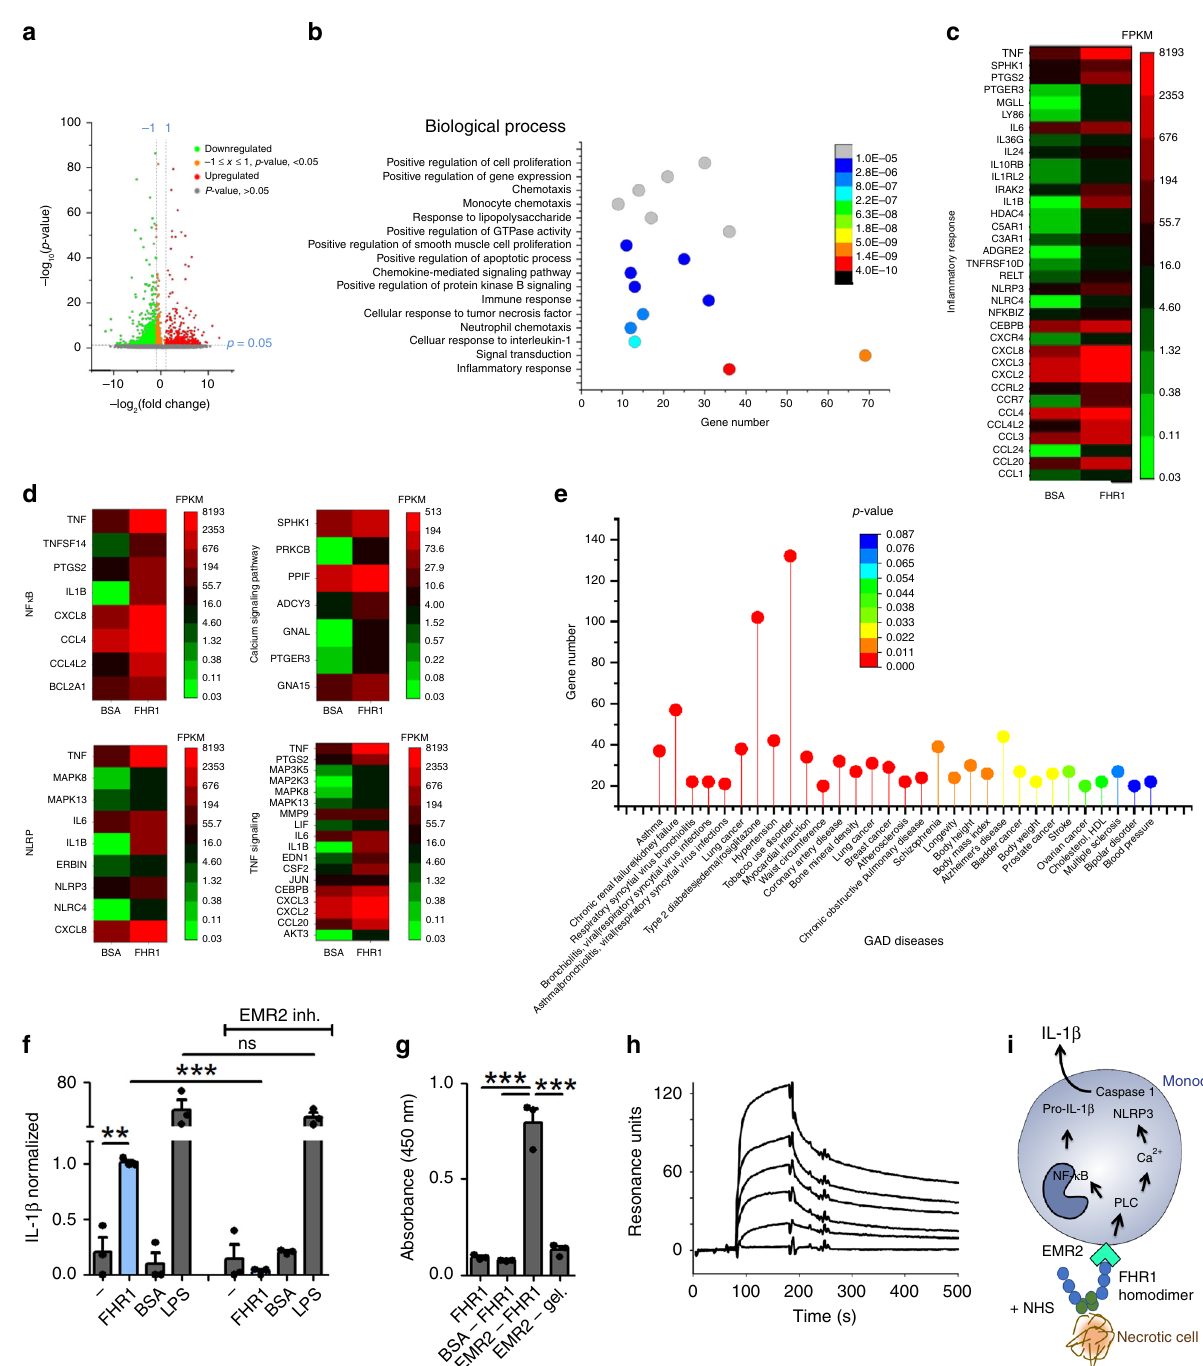
Fig. 4 FHR1 binds to G protein-coupled receptor EMR2. a Genes differentially expressed in monocytes exposed for 4 h to FHR1 and NHS. b Biological processes involved in FHR1 induction (GO classi fi cation). c In fl ammatory genes and d signaling pathways induced in monocytes by FHR1. e Upregulated genes in response to FHR1 show signi fi cant overlap with upregulated genes in certain diseases. f IL-1 β induction by FHR1 is blocked by inhibition of EMR2 ( α EMR2). g Recombinant EMR2 binds to FHR1 but not to gelatine (gel.) in ELISA. h The bond between EMR2 and FHR1 is in a dose-dependent manner shown via surface plasmon resonance technique. i Schematic overview of FHR1-induced IL-1 β generation pathway in monocytes. Data in a – h represent the mean ± SEM of three to four independent experiments with cells from different donors. ** p ≤ 0.01, *** p ≤ 0.001 (unpaired two-tailed t